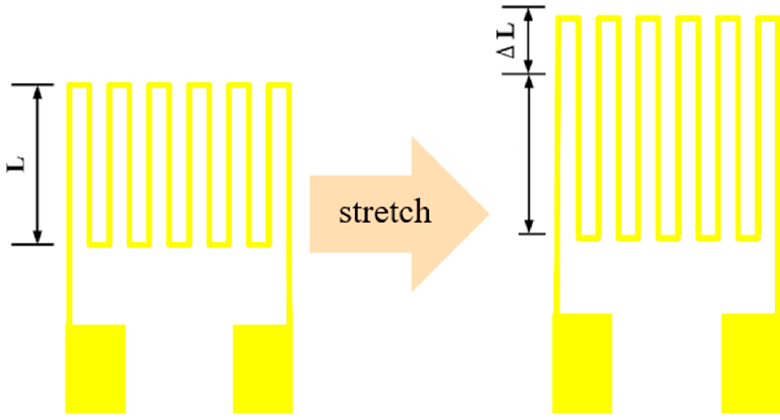
Figure 2. Principle and design of micro-strain sensor.